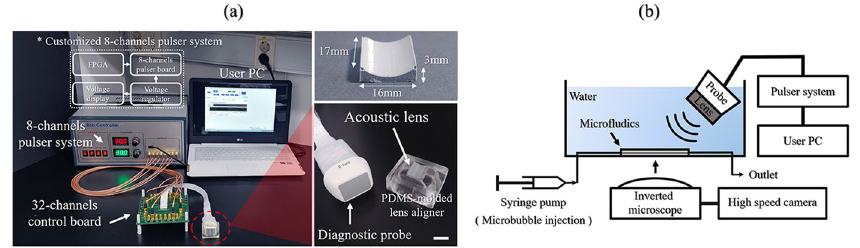
Figure 6. Complete ultrasonic system for the experimental study. ( a ) Photographs of the UUS-mediated DDS with the attachable acoustic lens (scalar bar = 1 cm) and the custom-built ultrasonic pulser system. ( b ) An illustration of the in vitro experimental setup. Ultrasonic waves were emitted with an incident angle of 45° to prevent a standing wave effect in the